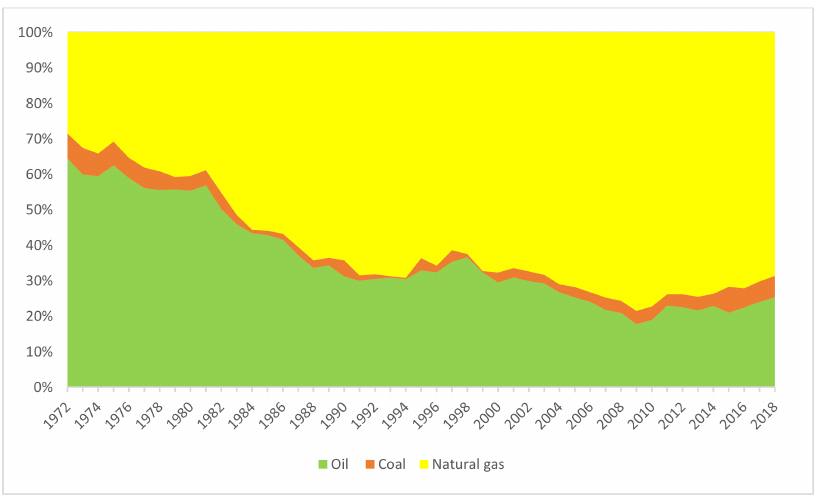
Figure 3. Proportion of primary energy consumption by conventional sources (%) in